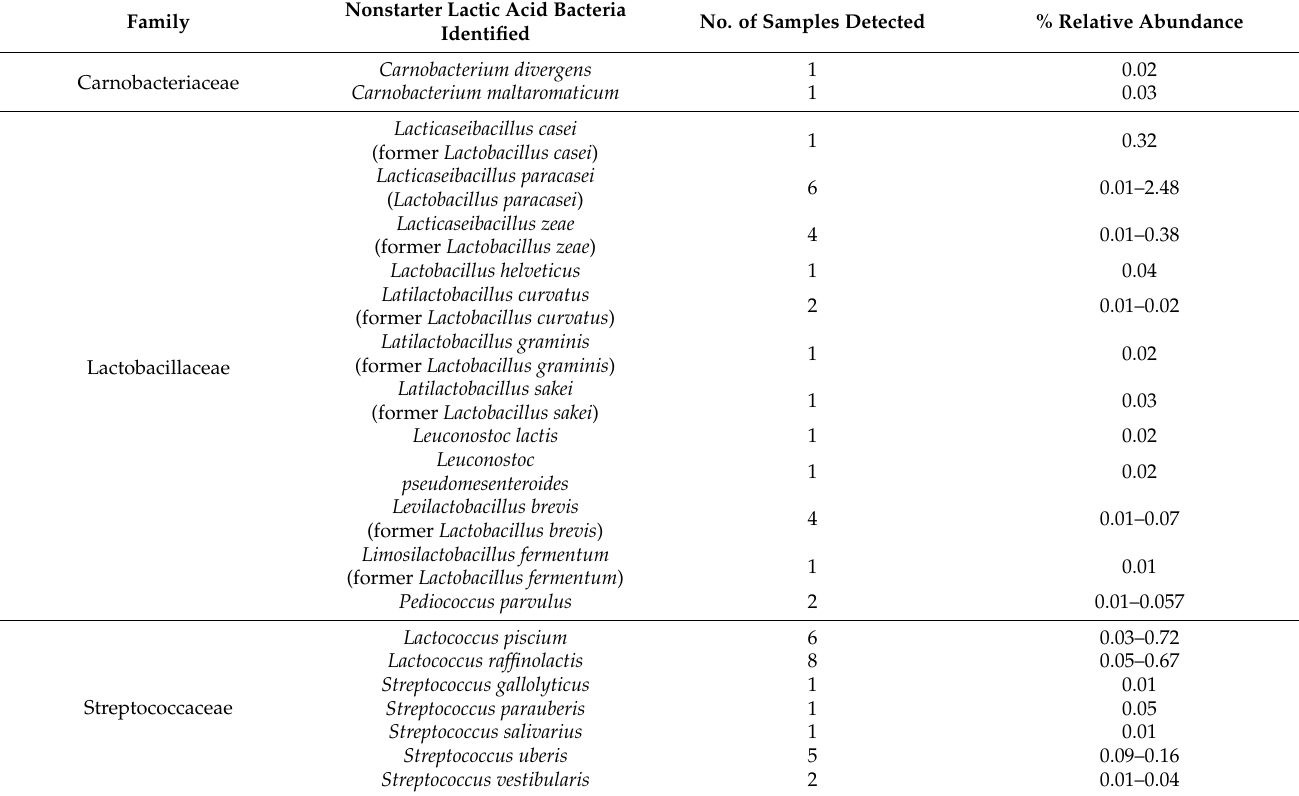
Table 1. Species of nonstarter lactic acid bacteria (NSLAB) identified in the feta cheese samples.